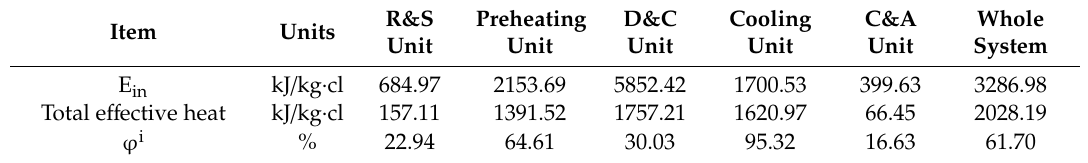
Table 5. Thermal e ffi ciency of one 5000 MT / D production line before